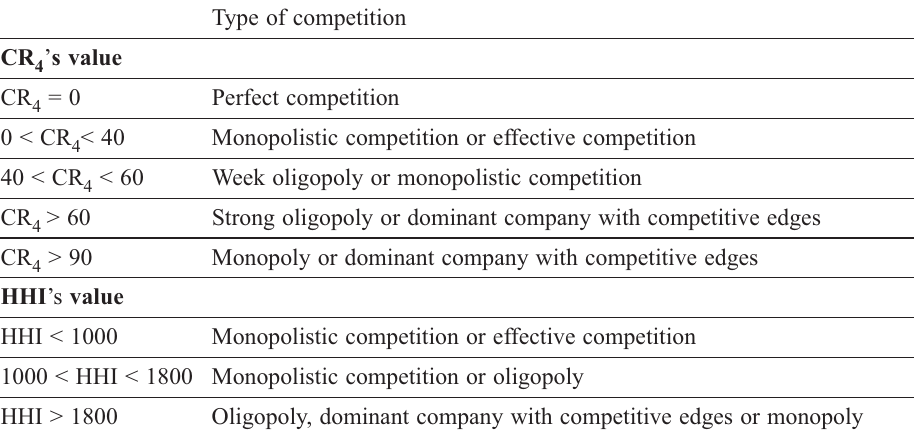
Table 1 . The classifi cation of the sectors of activity considering the CR and